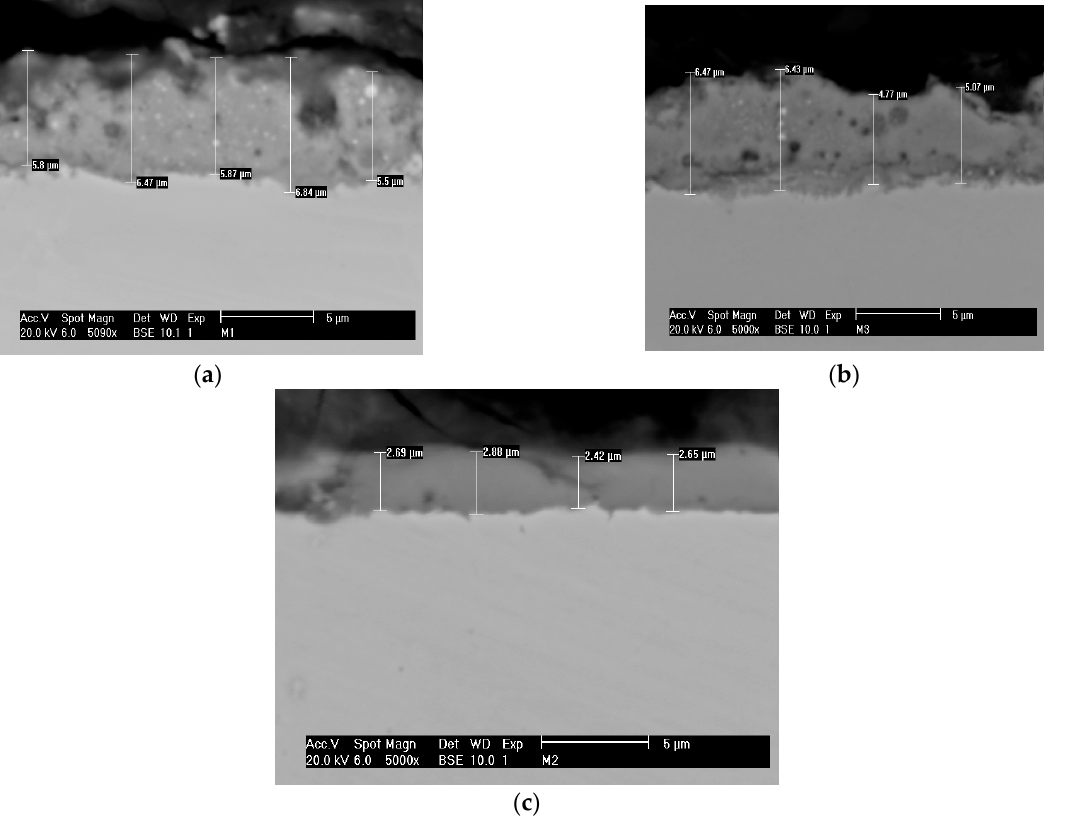
Figure 3. Cross-sectional analysis of oxy-nitrided AISI 304 SS using: ( a ) 20 wt% urea, ( b ) 30 wt% urea and ( c ) 40 wt% urea, 5000× magnification using the scanning electron microscope and backscattered electrons.